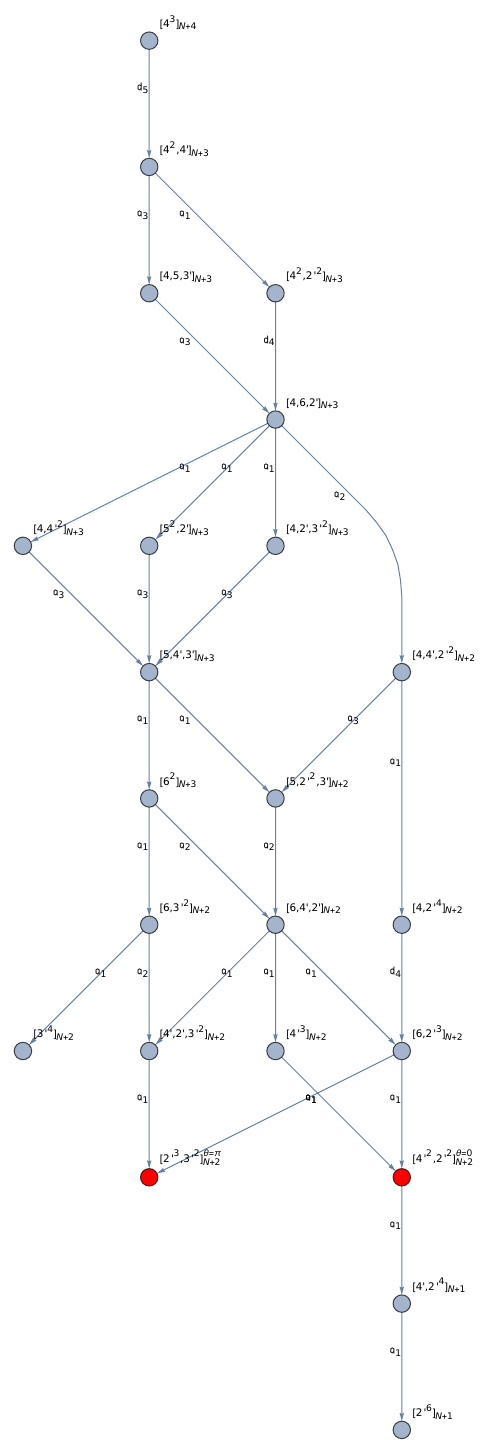
Figure 8. Hierarchy for massive E 5 -theories with n 0 = 4 and k = 16